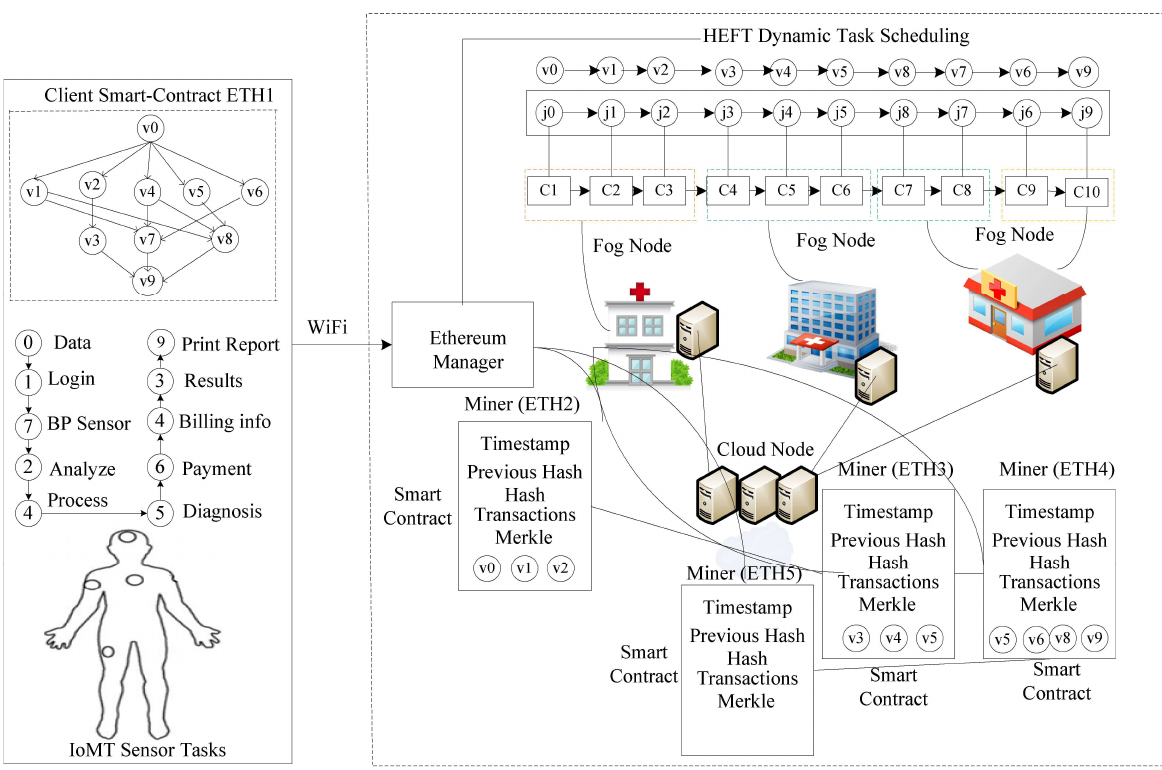
Figure 2. System